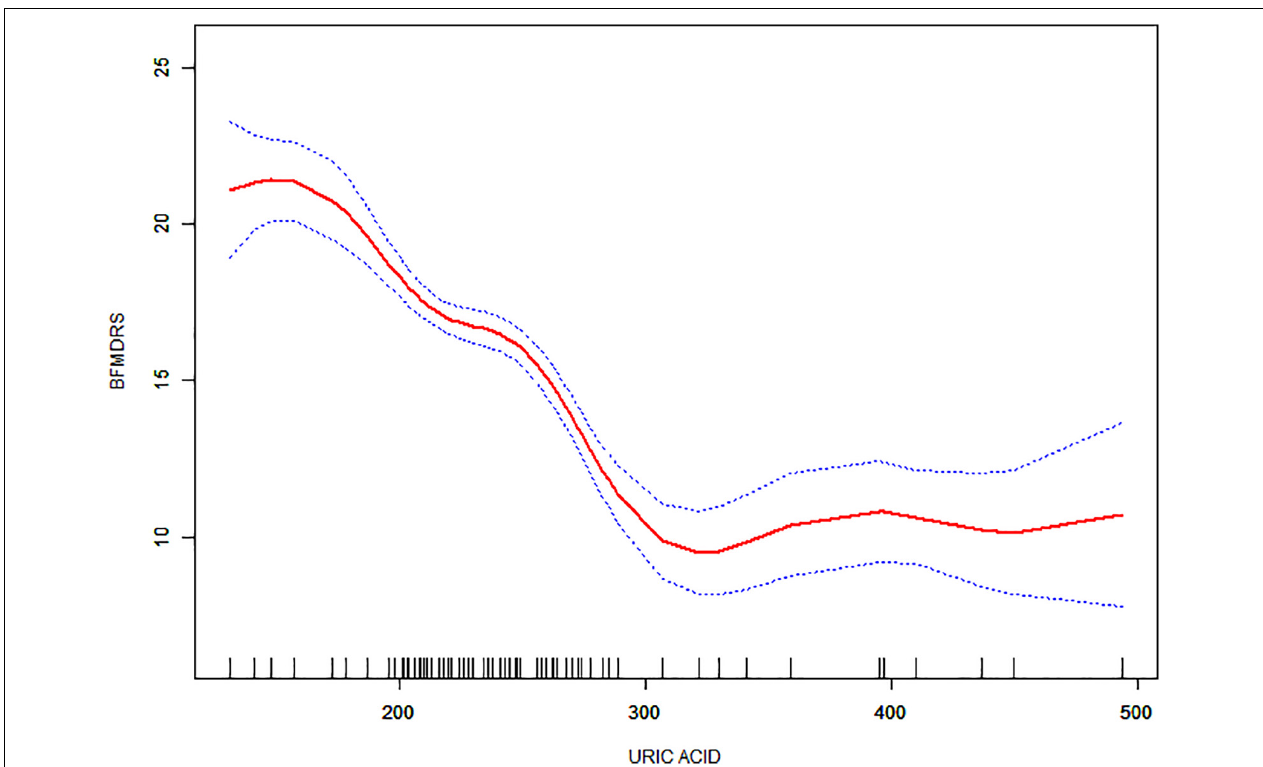
FIGURE 3 | The association between serum uric acid levels and Burke-Fahn-Marsden dystonia rating scale scores. A non-linear relationship was observed, and a threshold serum uric acid of 330 µ mol/L existed for the regulation of uric